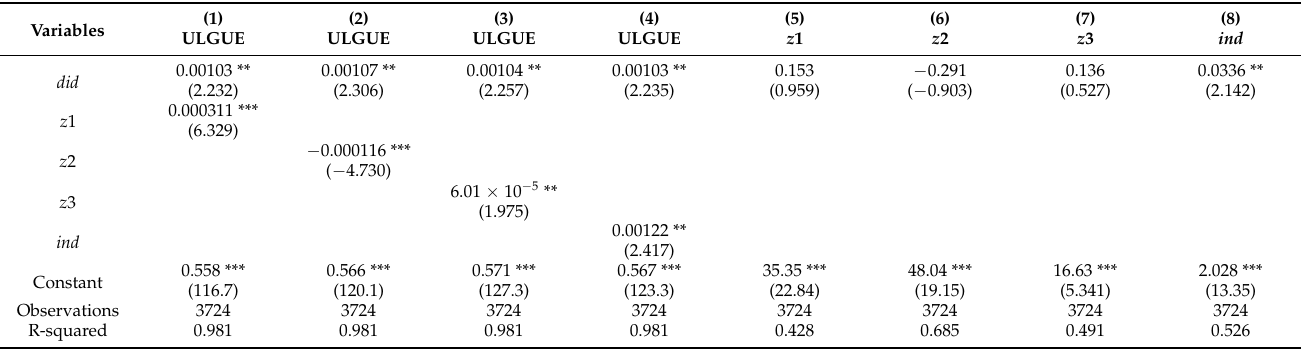
Table 7. Empirical analysis of impact of industrial structure on